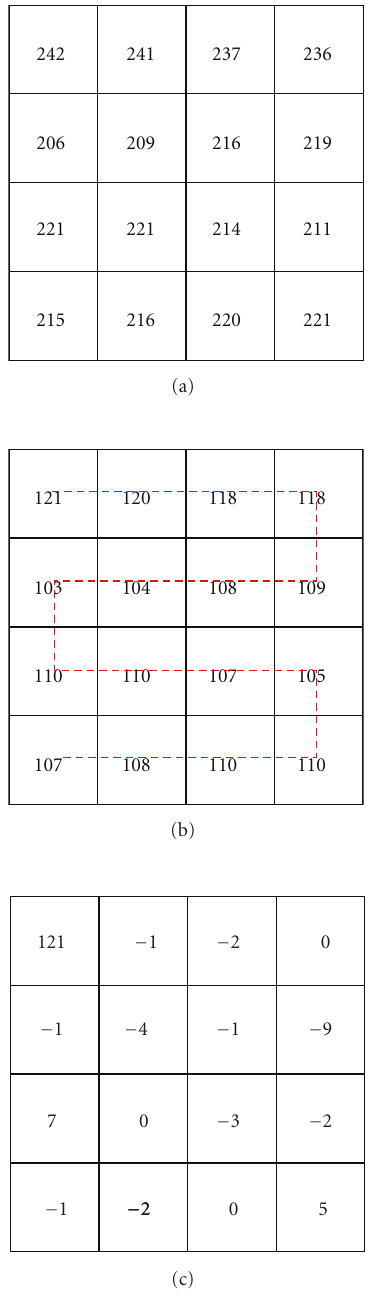
Figure 5: An example of 4 × 4 block: (a) Input 4 × 4 pixel values, (b) 4 × 4 pixel values after quantization by QP = 1, and (c) DPCM results.